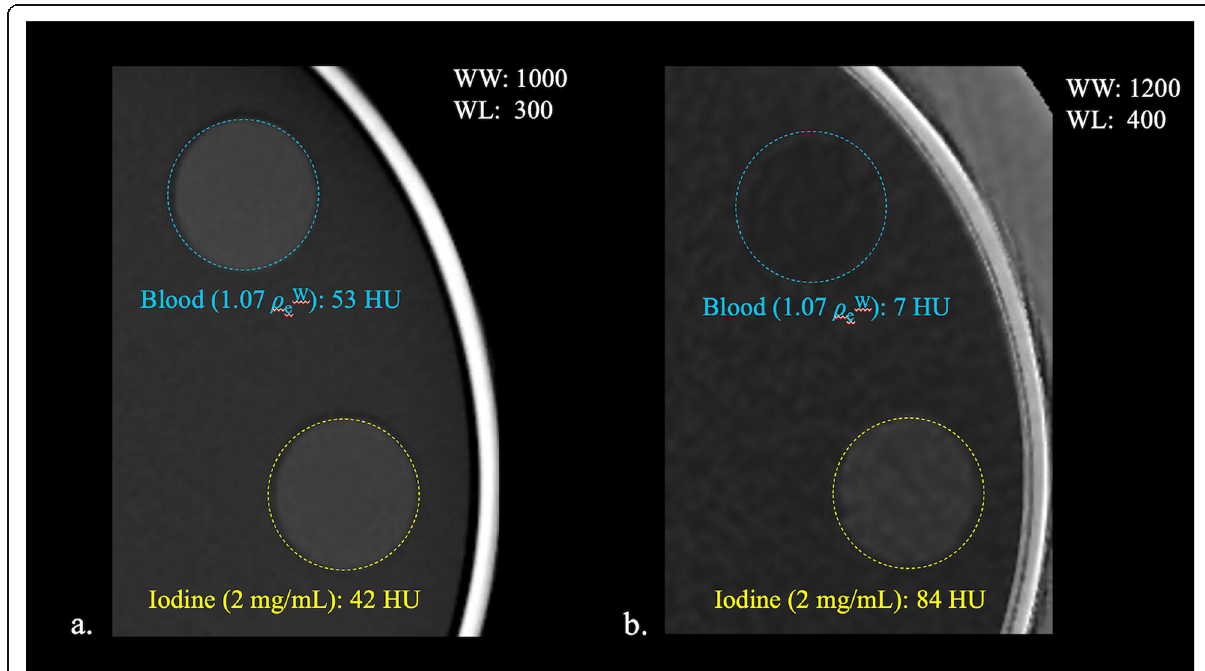
Fig. 3 Representative phantom images with x-ray attenuation rubber covering with a focus on the difference between blood (blue dashed circle) and iodine (2.00 mg/mL) (yellow dashed circle). a There is almost no visual difference between the blood and iodine in the virtual monoenergetic (VME) image. b The two regions can be clearly differentiated in the iodine